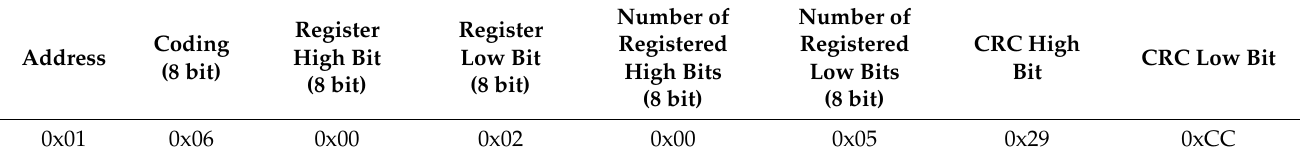
Table A3. The requirements format sending from Host (RX64M) to RoLa module.